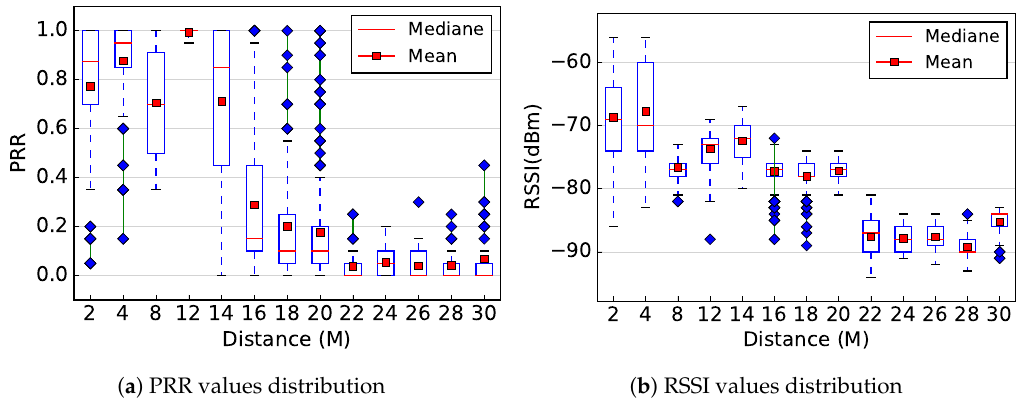
Figure 12. Correlation between the PRR/RSSI and the distance (please not that the x -axis is not